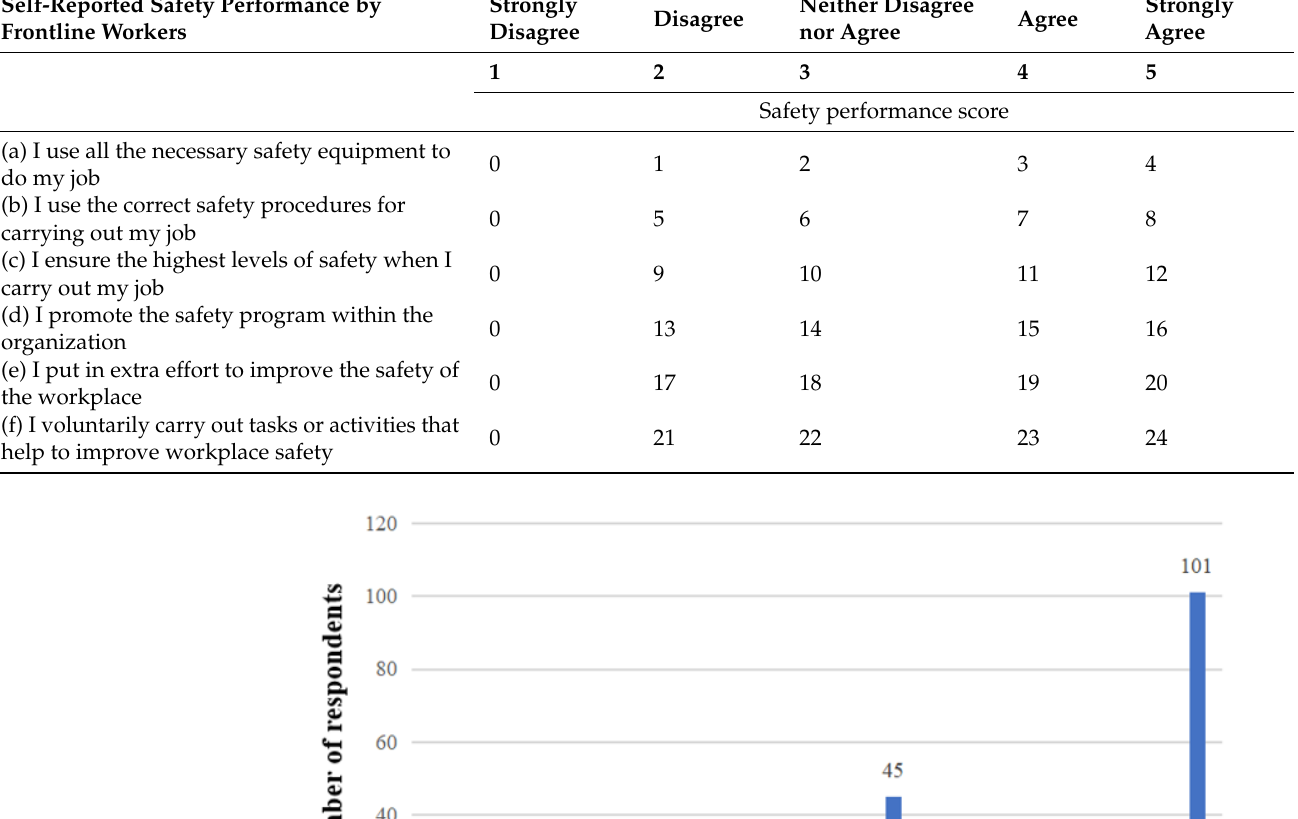
Table 7. Cumulative calculation rules for safety performance scores.